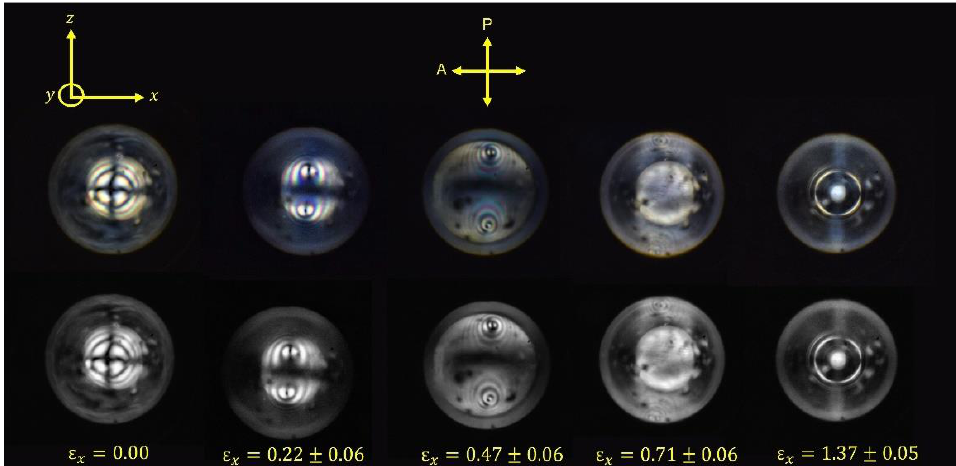
Figure 9. Conoscopic patterns for the homeotropically aligned LCE. The initial nematic director is aligned along the y -axis and strains are applied along the x -axis with a polarizer and analyzer aligned along the x - and z -axis respectively. The development of two melatopes with applied strain (increasing strain from the left to the right of the figure) is indicative of biaxiality within the system. The bottom row shows grey-scaled images of the top row.